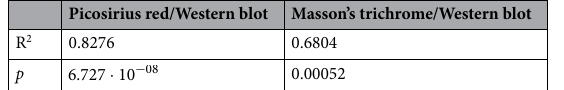
Table 2. Regression analysis of scatter plots presented in Fig. 5F,I.